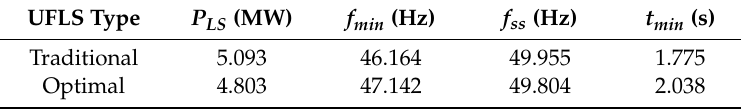
Table 6. Frequency quality metrics of low inertia—winter season scenario.